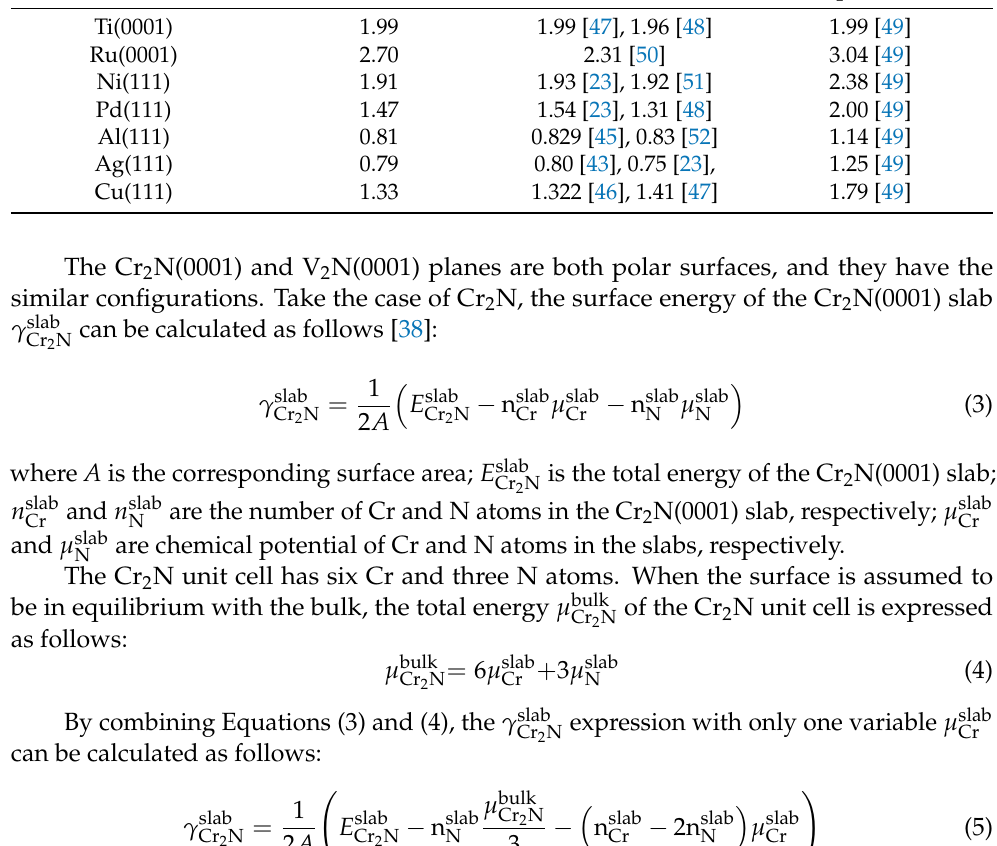
Table 3. Calculated surface energies of Ti(0001), Ru(0001), Ni(111), Pd(111), Al(111), Ag(111), and Cu(111) surfaces. The corresponding data available in the literature are also included for comparison. Surface Energy (J/m 2 ) Metal Slab This Work Other Calculations Experiment